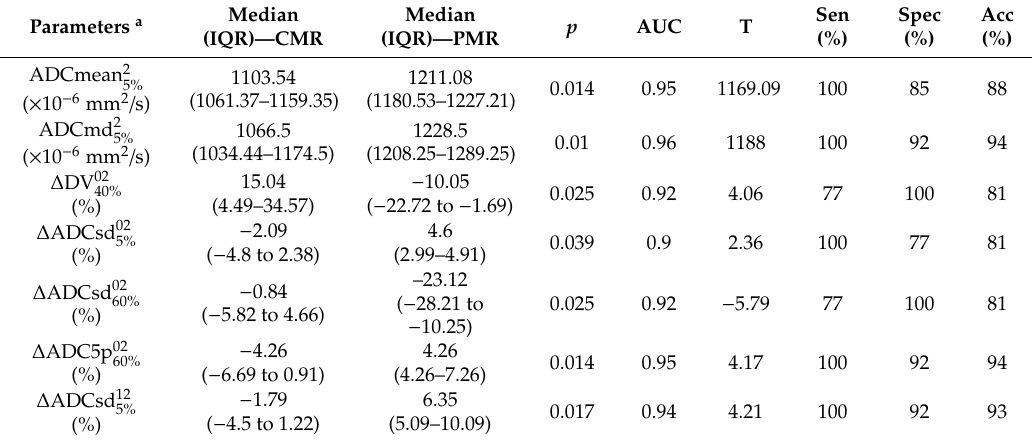
Table 6. Significant results for assessment of end-of-treatment